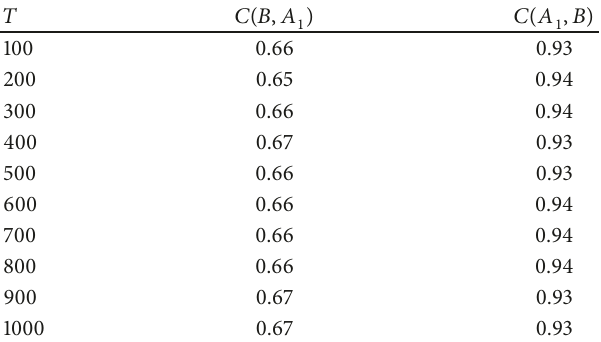
proposed concurrent search method. Results are shown for DTLZ3, 𝑚 = 2 original objectives, 𝑀 = 4 objectives in